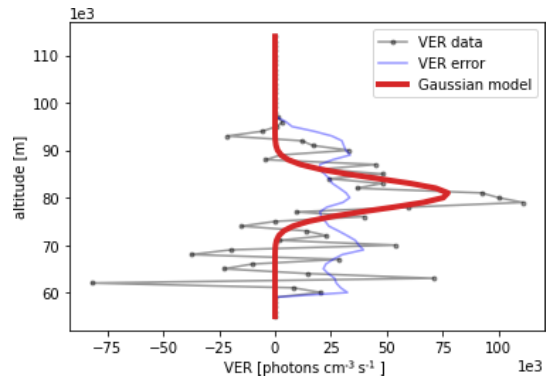
Figure 6. The fitted Gaussian model (red), the volume emission rate (VER) profile (grey) and the error profile of the VER (blue), which is the first profile taken in orbit 10122 (see Fig. 7 for the whole orbit). Note that only the grid points associated with an averaging kernel (AVK) maximum at a row larger than 0.8 are used for the fitting, i.e. an altitude from 60 to 95km (refer to Fig. 5). The fitted Gaussian parameters are as follows: V peak = 7 . 76( ± 1 . 51) × 10 4 photonscm − 3 s − 1 , z peak = 80 . 8 × 10 3 ( ± 563)m and σ = 3 . 2 × 10 3 ( ±